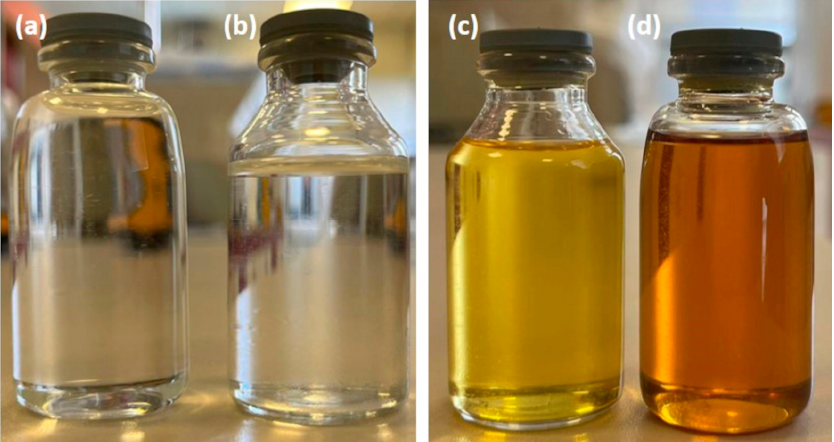
Figure 1. ( a ) Light naphtha, ( b ) heavy naphtha, ( c ) Py oil-1; the oil collected between 270–300 °C, ( d ) Py oil-2; the oil collected between 370–400 °C.